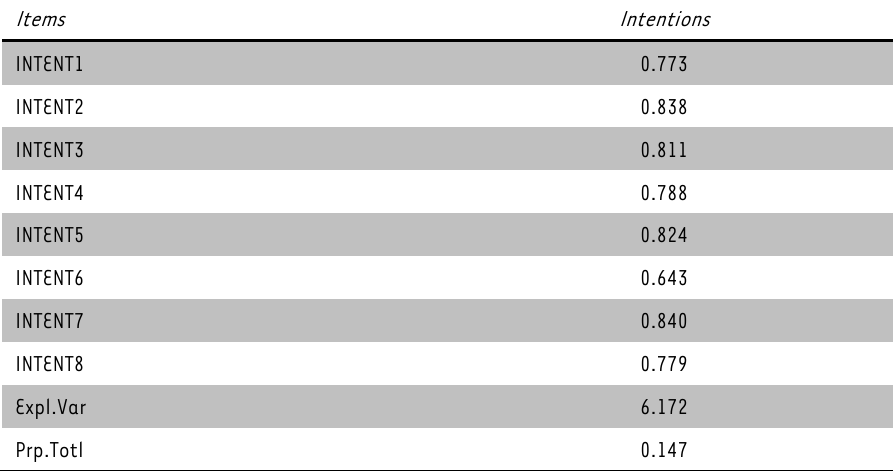
TABLE 2: Factor structure – dependent variable Items